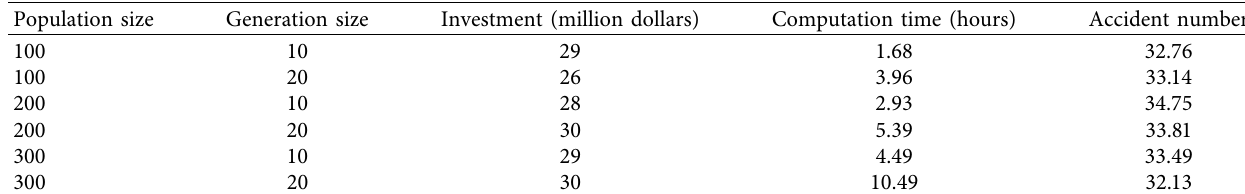
Table 2: Multiple GA tests with varying population and generation size.